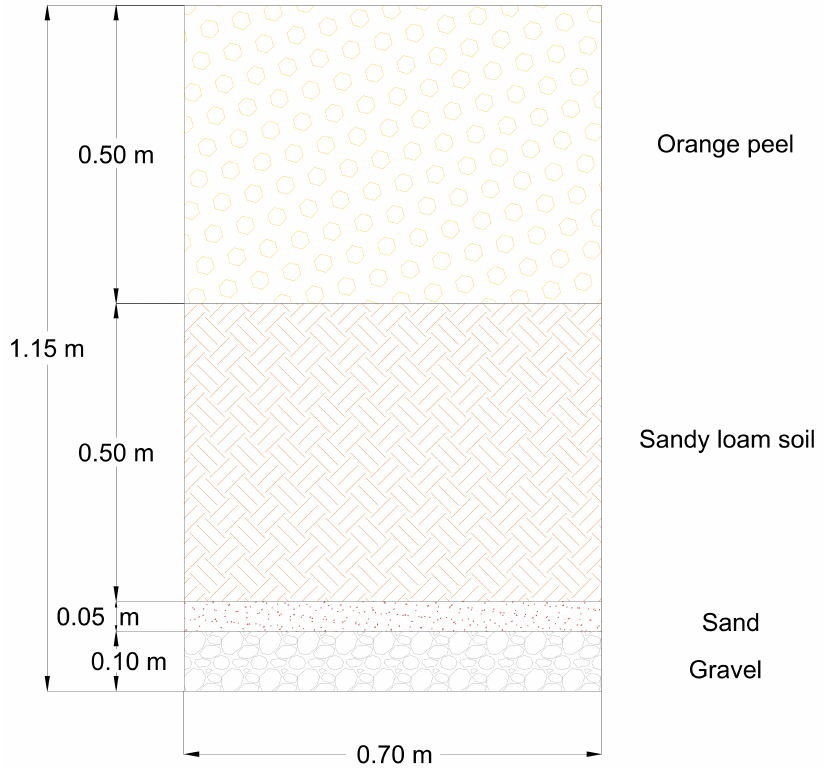
Figure 1. Layout of the orange peel/soil column at the start-up of each lysimetric test. Three drainage tests were carried